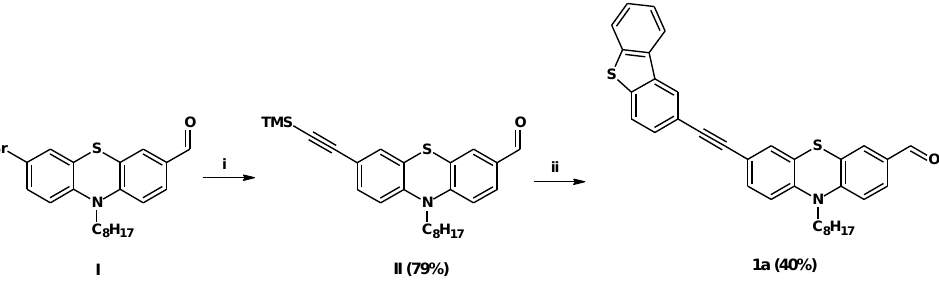
Scheme 1. Synthetic route for the preparation of compounds 1a . Reagents and conditions: (i)